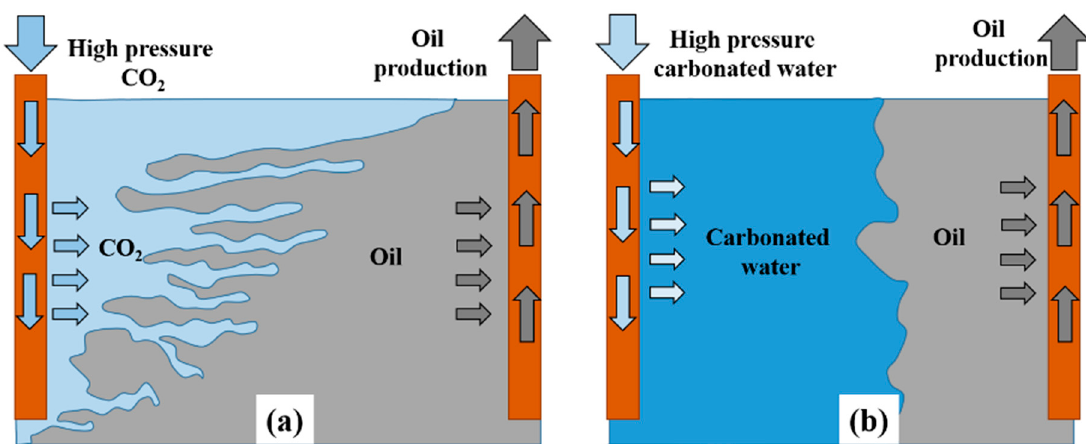
Figure 1. Pictorial representation of sweep front for the case of ( a ) CO 2 flooding and ( b ) Carbonated water injection.